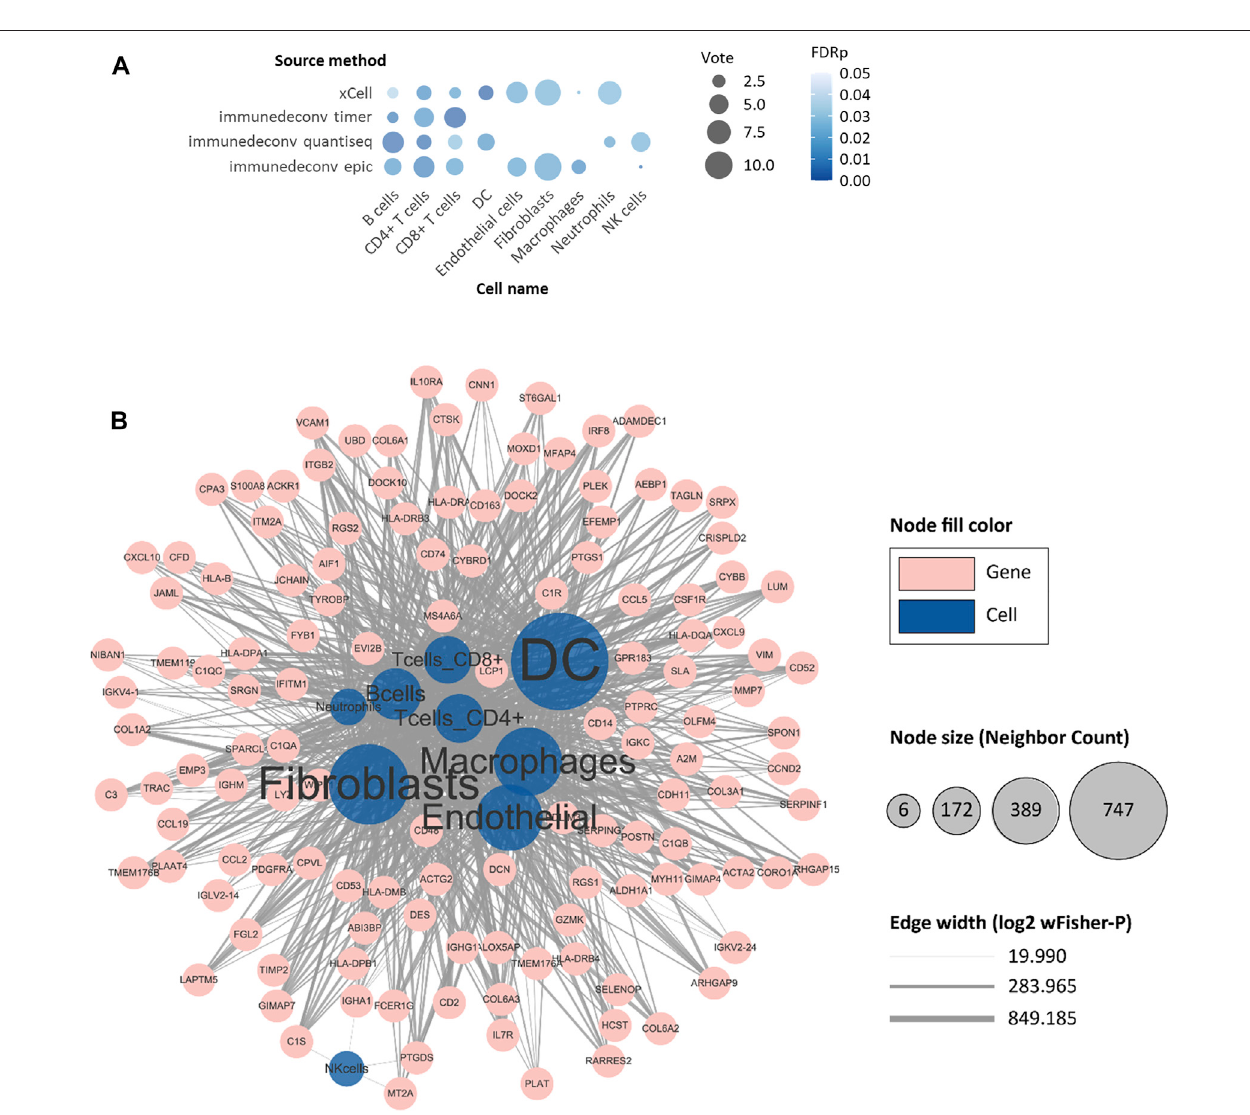
FIGURE 2 | Identi fi cation of progression-risk-related tumor-in fi ltrating cells and differentially expressed genes representing them. (A) The non-weighted voting results of Student ’ s t-tests between tumor-in fi ltrating cells and well-established clinical progression risk factors. Tumor-in fi ltrating cell scores evaluated by six immune deconvolutionmethodswereused.Onlysigni fi cantresultswerecountedasvalidvotesshowninthe fi gure. (B) Thenetworkofdifferentiallyexpressedgenes(DEGs)with their representing tumor-in fi ltrating cells. The blue circles refer to cell types. The pink circles refer to selected DEGs. The size of blue circles indicates the number of DEGs.Thethicknessoflinesindicatesthenegativelog2ofwFishercombined p -valueofdifferentialexpressiontesting.Onlynodeswithmorethansixadjacentneighbors are